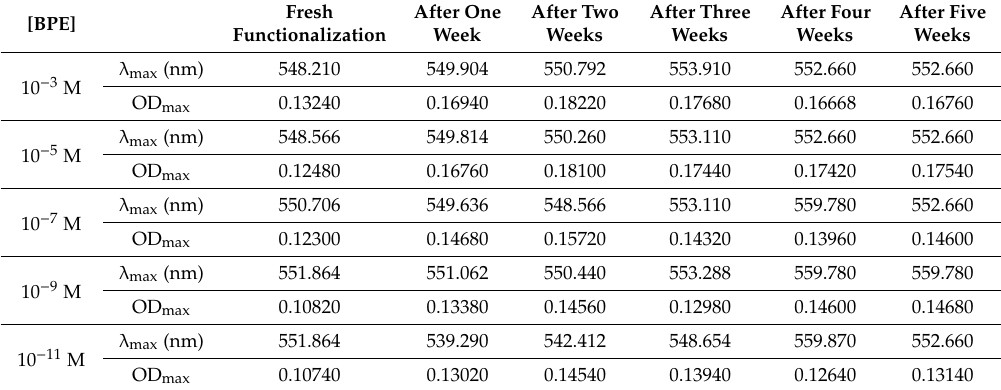
Figure 8. Evolution of maximum optical density (OD max ) of annealed AuNPs functionalized with five BPE concentrations over five weeks (fresh—the day of functionalization). The coverslip was evaporated with 4 nm Au and annealed at 550 °C for 3 h. Table 1. Evolution of LSPR spectra of AuNPs functionalized with di ff erent BPE concentrations over five weeks. The LSPR measurements were performed under cleanroom conditions at 21 ◦